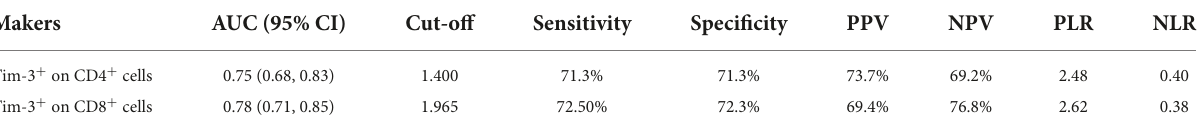
TABLE 4 Predictive values of each